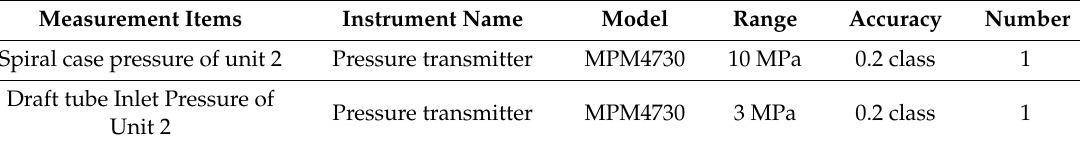
Table 4. Pressure sensor parameters for test.